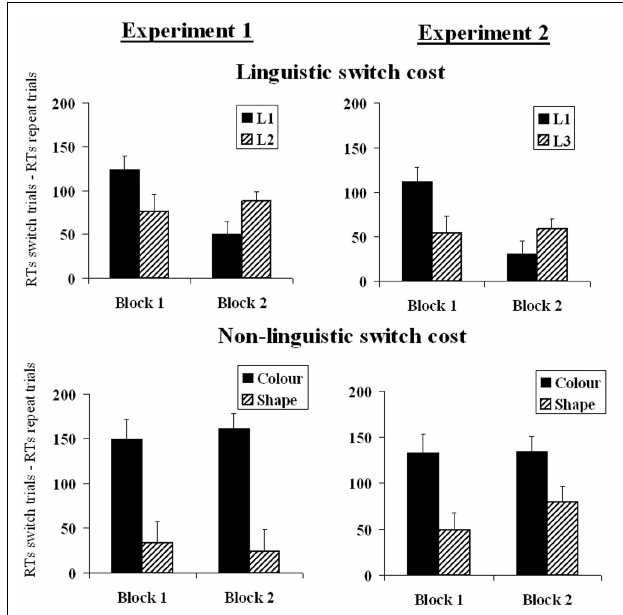
FIGURE 4 | Magnitude of the switch costs in the linguistic and non-linguistic switching tasks broken by blocks and experiments. Error bars represent